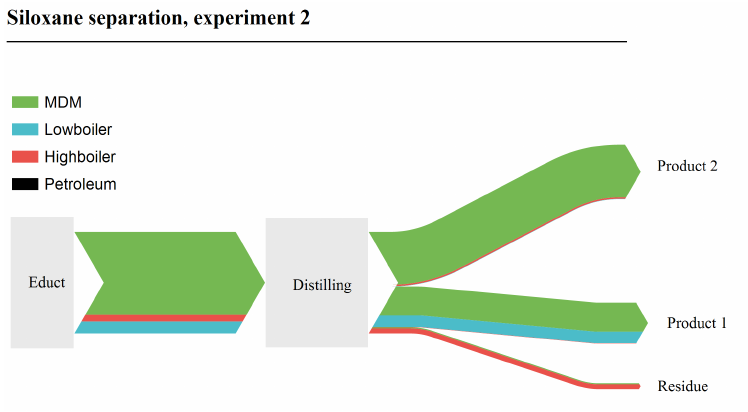
Figure 7. Sankey diagram of mass flows for distilling Experiment